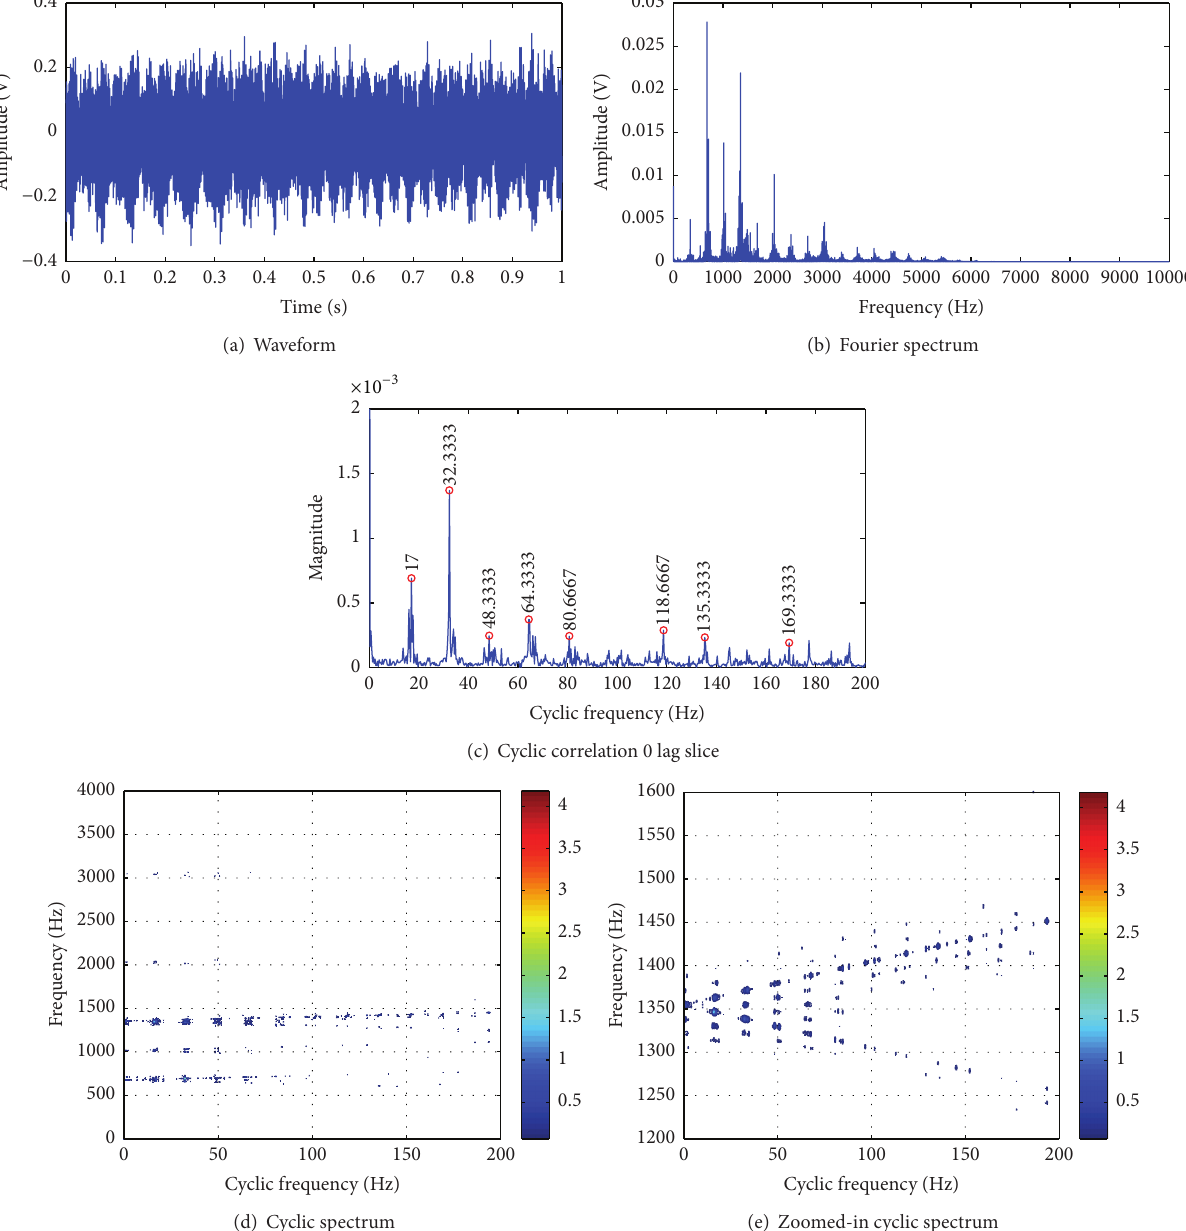
Figure 3: Healthy gearbox